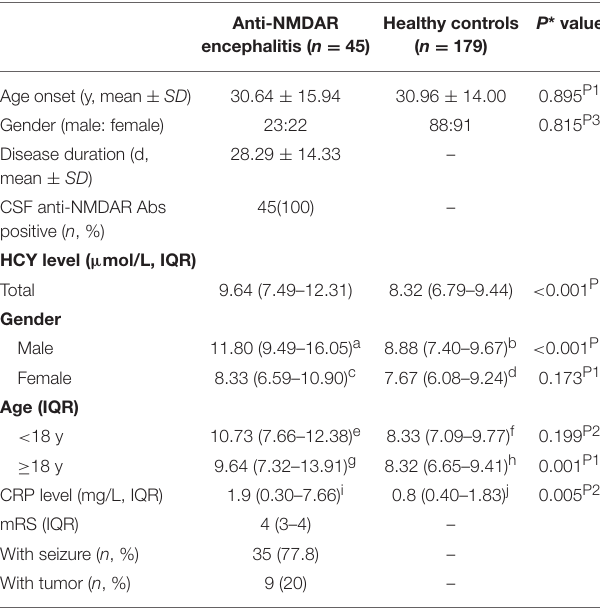
TABLE 1 | Demographic features of patients with anti-NMDAR encephalitis and healthy controls.